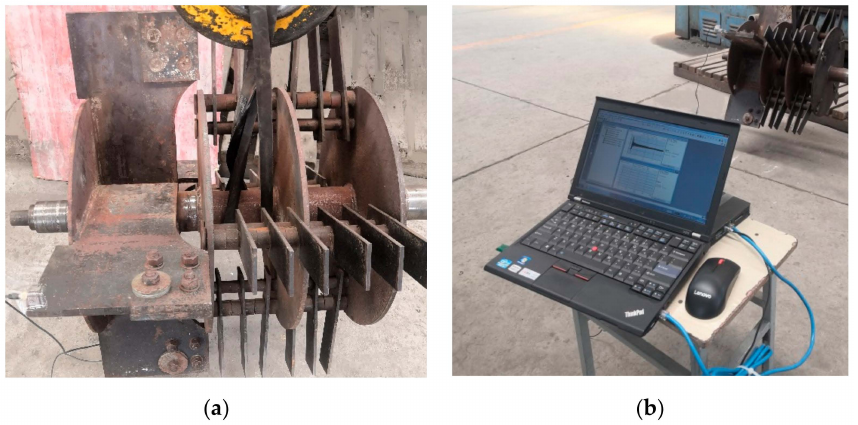
Figure 12. Site of the steel ball impact vibration test. ( a ) Sensor placement; ( b ) steel ball impact vibration test system.